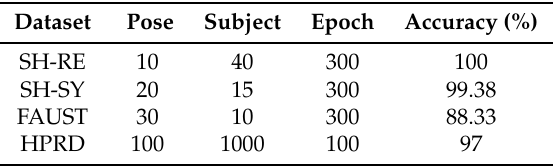
Table 2. Pose classification results of different datasets.